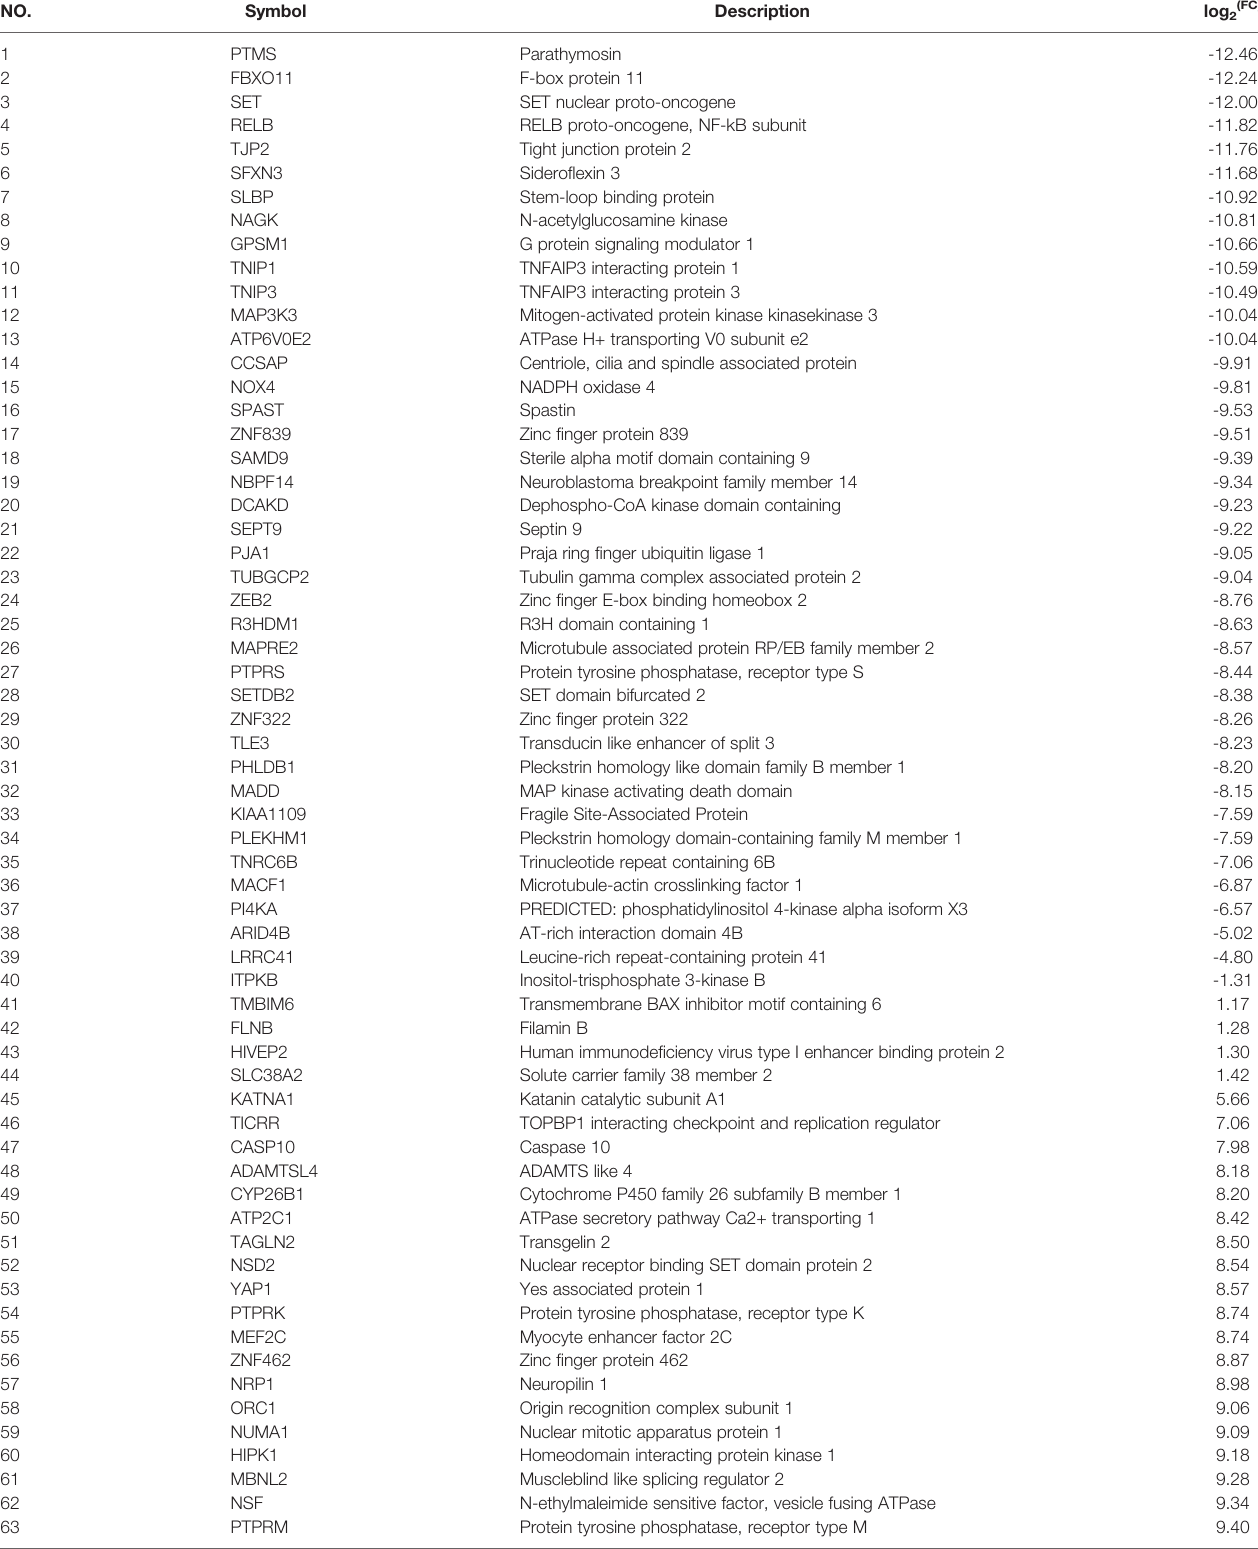
TABLE 2 | DEGs related to TAGLN2 overexpression in HUVECs identi fi ed using RNA-Seq analysis.